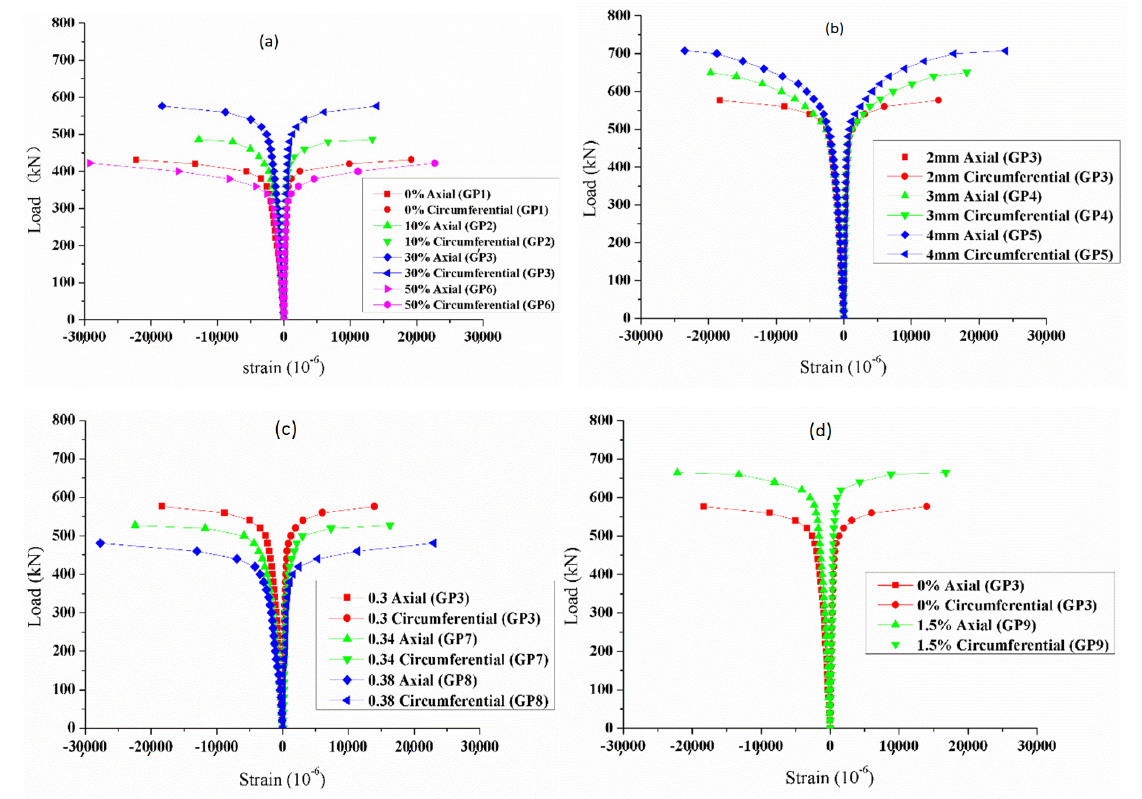
Figure 8. Different influence factors on the axial load–strain of CFSTs. ( a ) amount of GDS; ( b ) wall thickness; ( c ) W/B; and ( d ) amount of sodium sulfate.